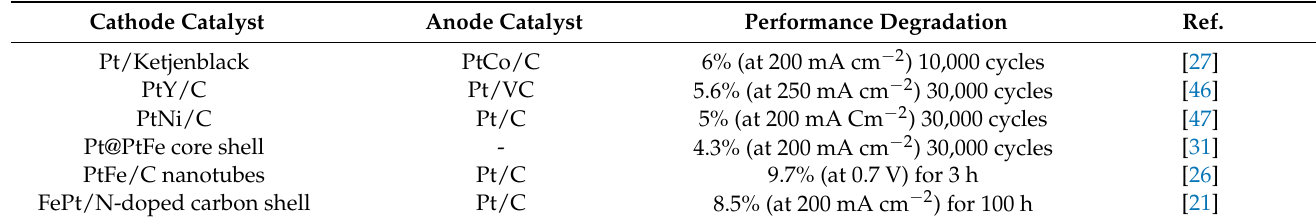
Table 1. Performance of various Pt and Pt-alloy cathode catalysts recently reported. Cathode Catalyst